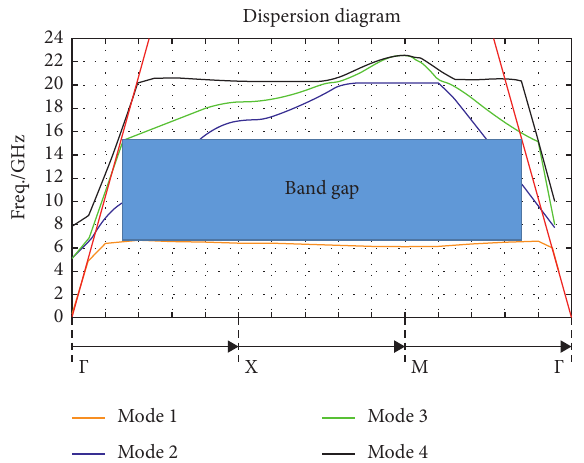
Figure 6: Dispersion diagram of the EBG unit (with red lines for the light cutoff frequency).